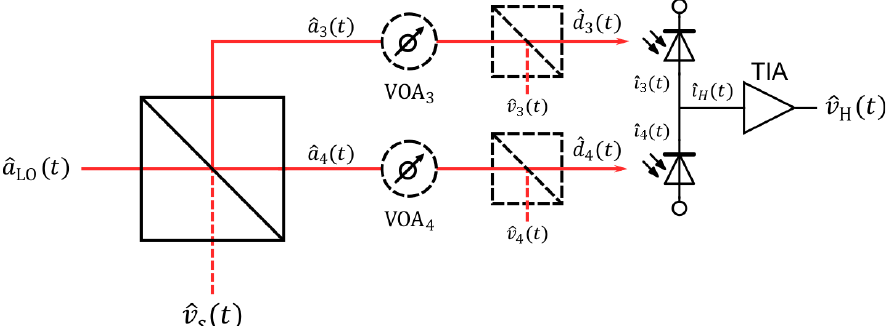
Figure 1. Representation of the homodyne detector (HD) model considered. Here, each variable optical attenuator (VOA) is obtained from a lossless BS. Similarly, each photodetector can be modeled by introducing a lossless BS before a theoretical perfect